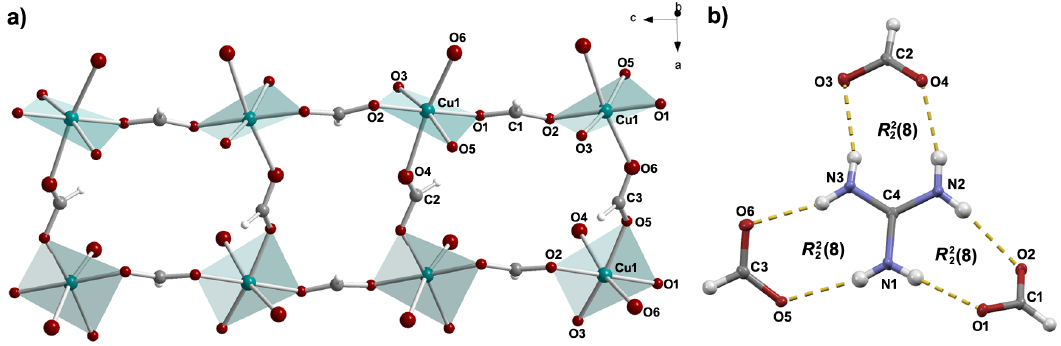
Figure 2. ( a ) The chains of CuO 4 units (defined by two short and two medium Cu–O bond lengths). The chains, which run along the crystallographic c -axis are formed via two medium Cu–O bonds of the formate anions. The chains further associate through long and short Cu–O distances, which involve formate anions. Guanidinium cations are not shown for clarity reasons. ( b ) Hydrogen bonds and the related graph-set notations formed by guanidinium cation. Hydrogen bonds are presented by yellow dashed